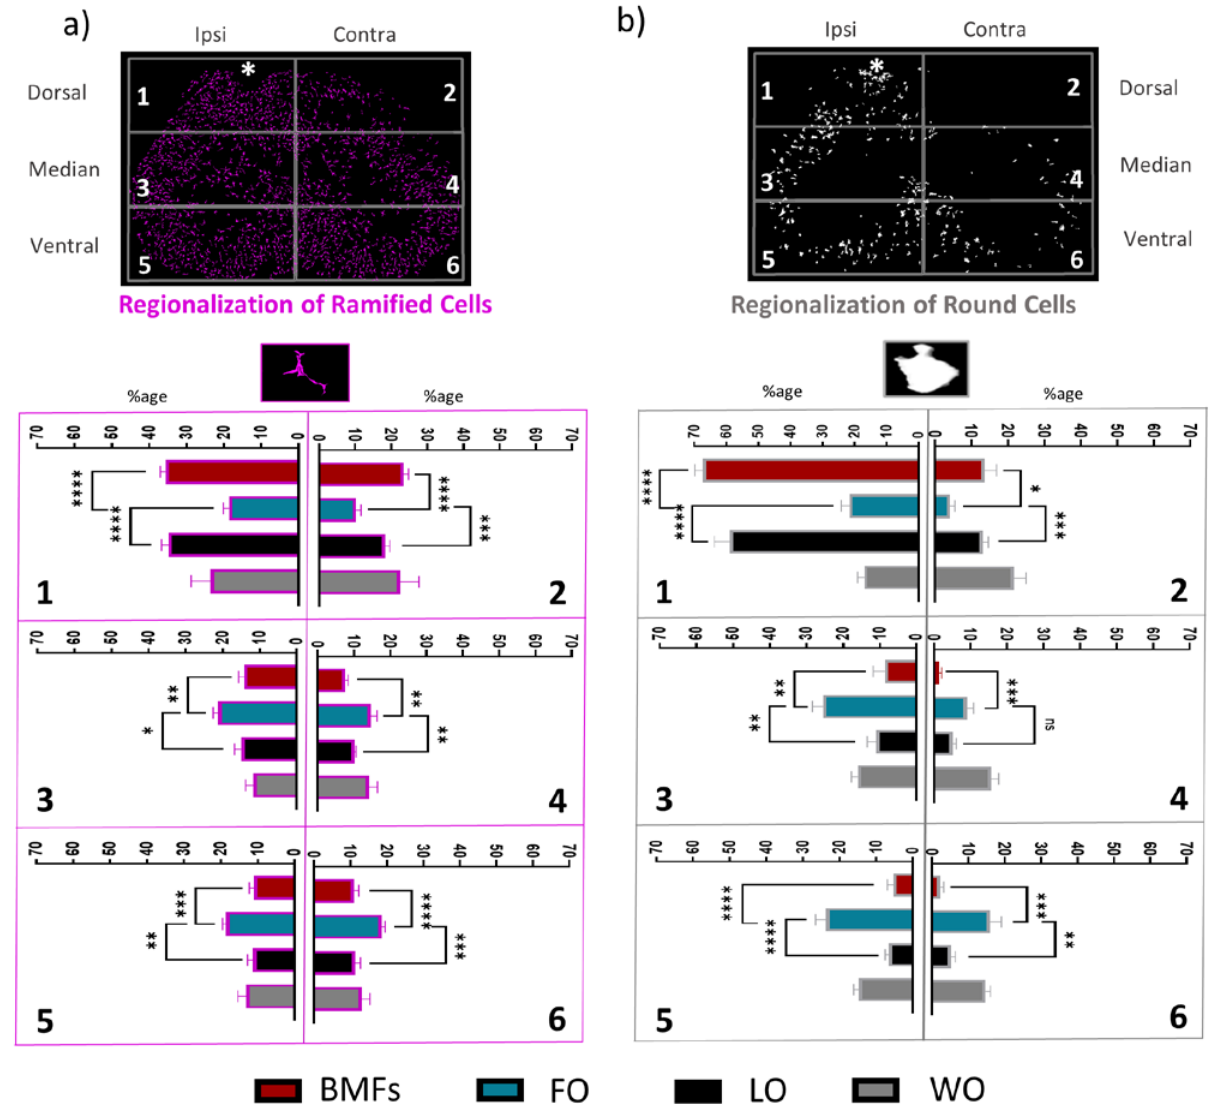
Figure 6. Dorsal and ipsilateral regionalization of chronic inflammation on D90 post lesion. ( a ) For each of the six rectangle ROIs, percentage of the total number of ramified CD11 + cells present in the section in each condition. ( b ) Same as ( a ) for round CD11 + cells. The white star indicates the lesion site. Results are displayed as mean ± SEM, n = 10 and * p < 0.05, ** p < 0.01, *** p < 0.001, **** p < 0.001.